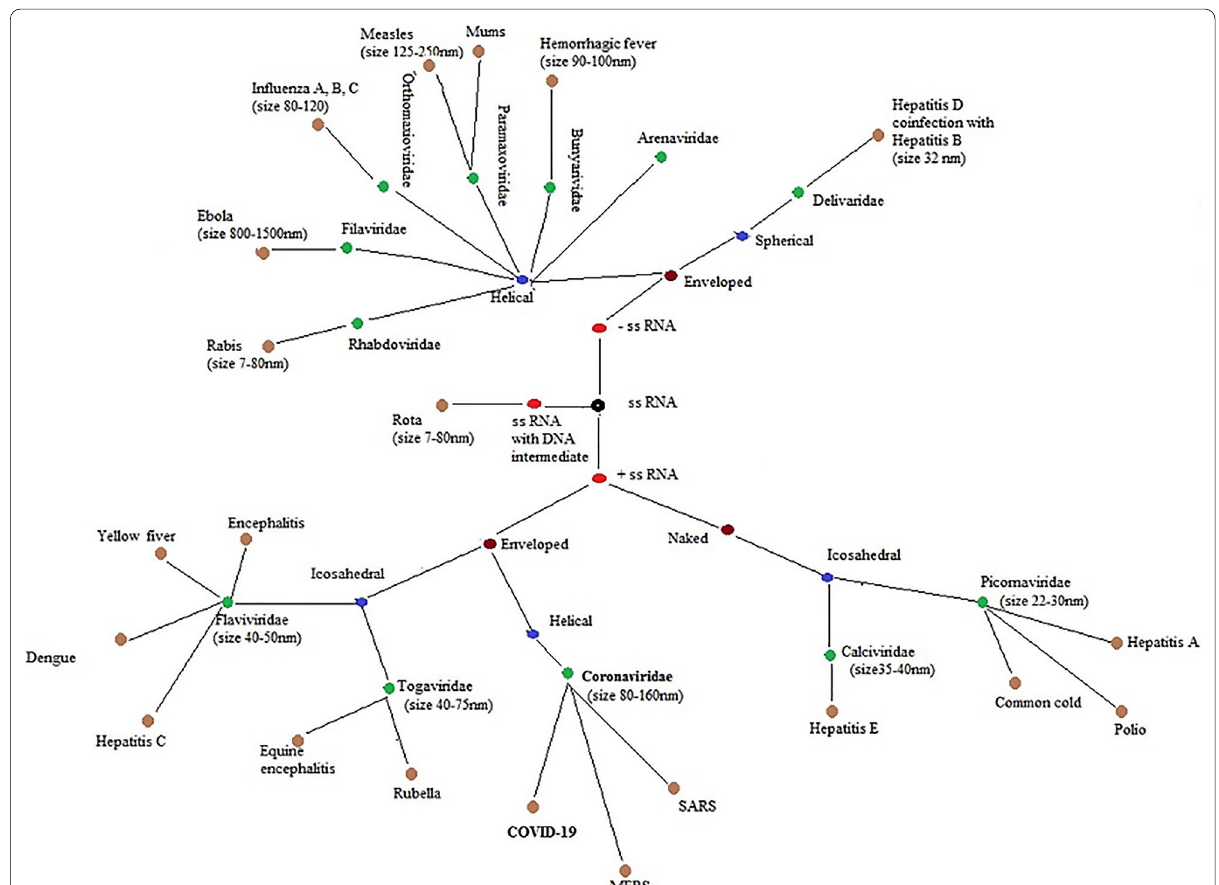
Fig. 1 Classification of RNA viruses is shown with different colors. ssRNA is classified mainly to viral subtypes that cause different diseases